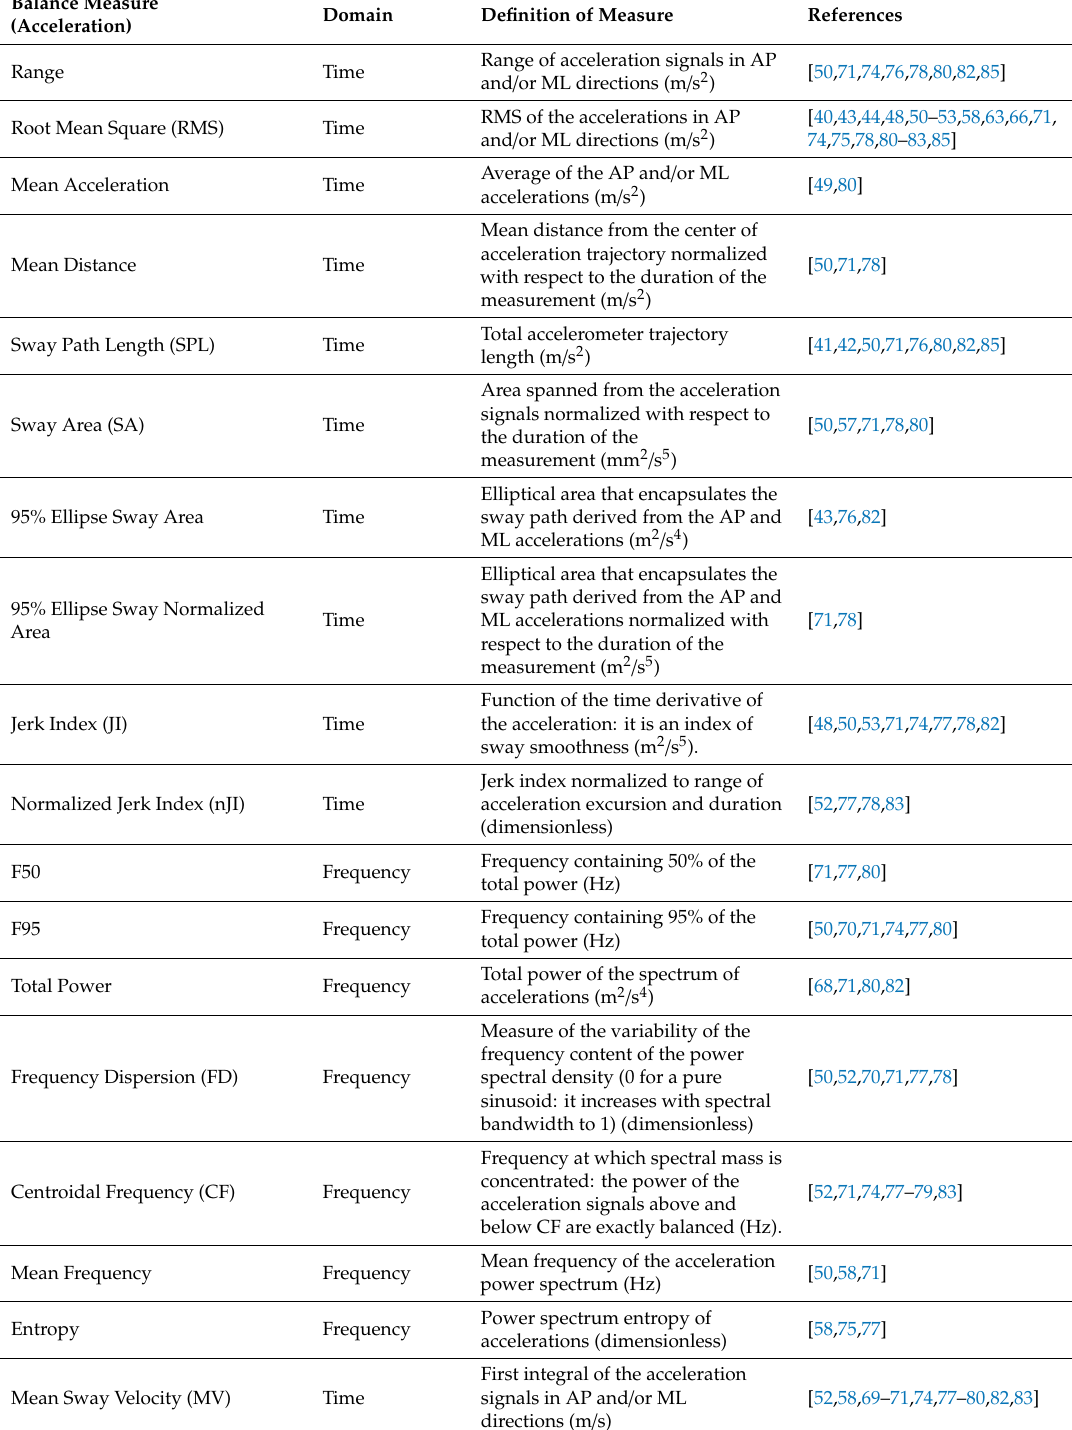
Table 5. Summary and brief description of the principal balance